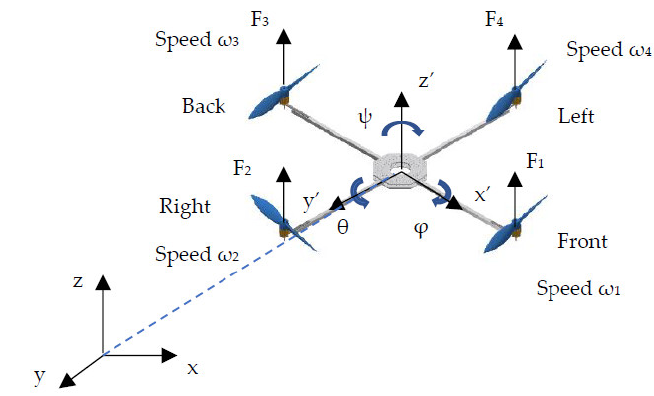
Figure 14. Quadrotor configuration.